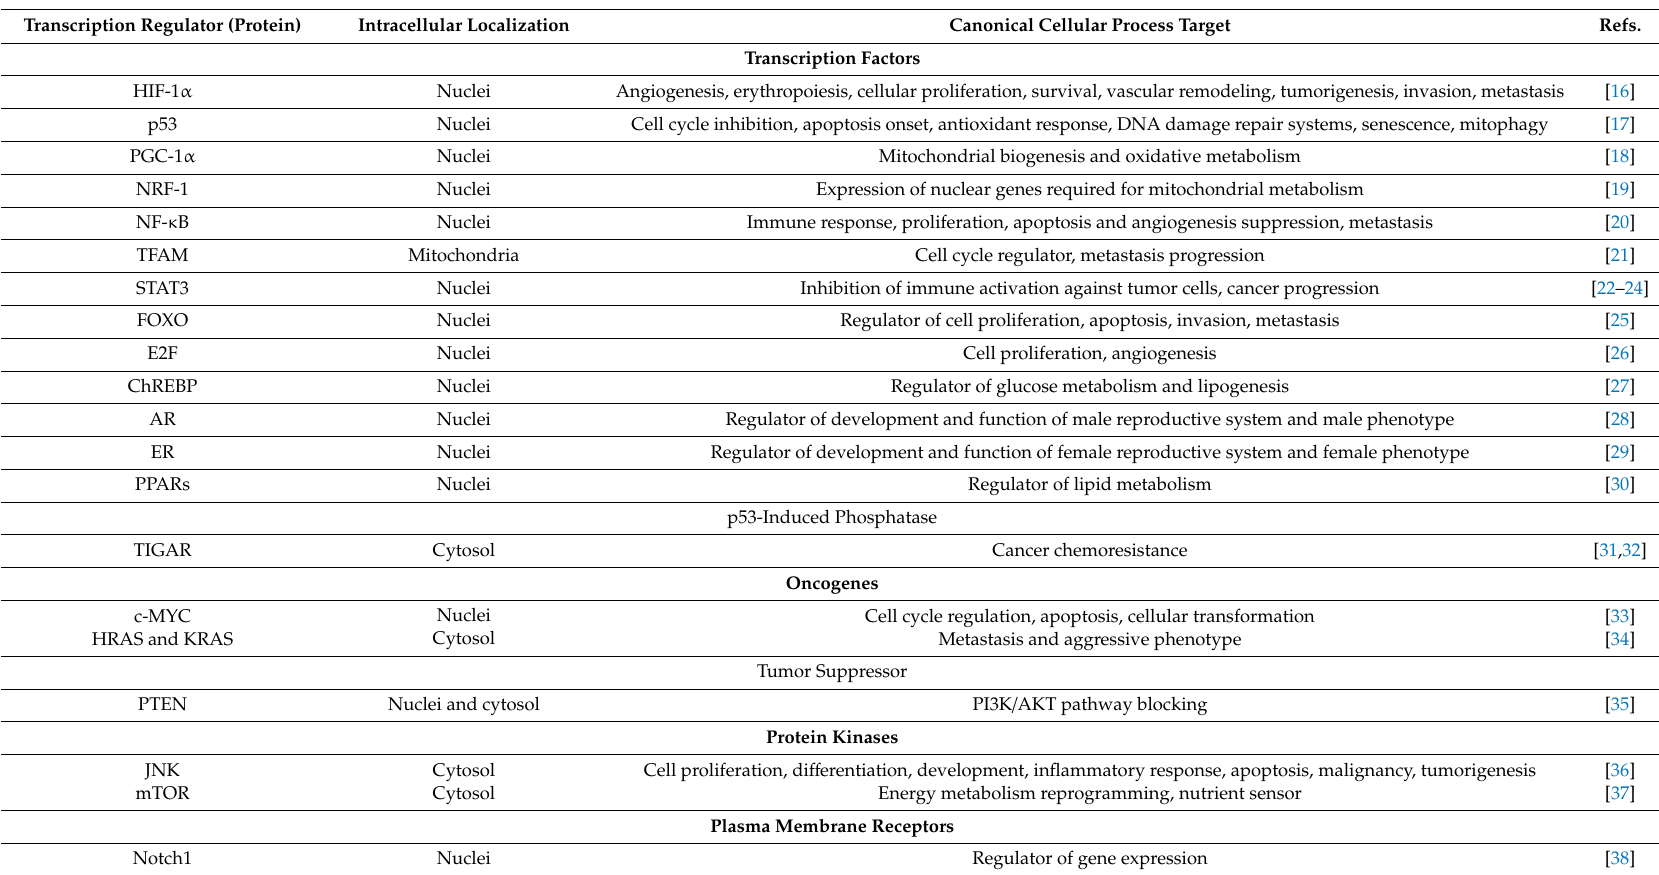
Table 1. Transcription regulators involved in several cancer cell